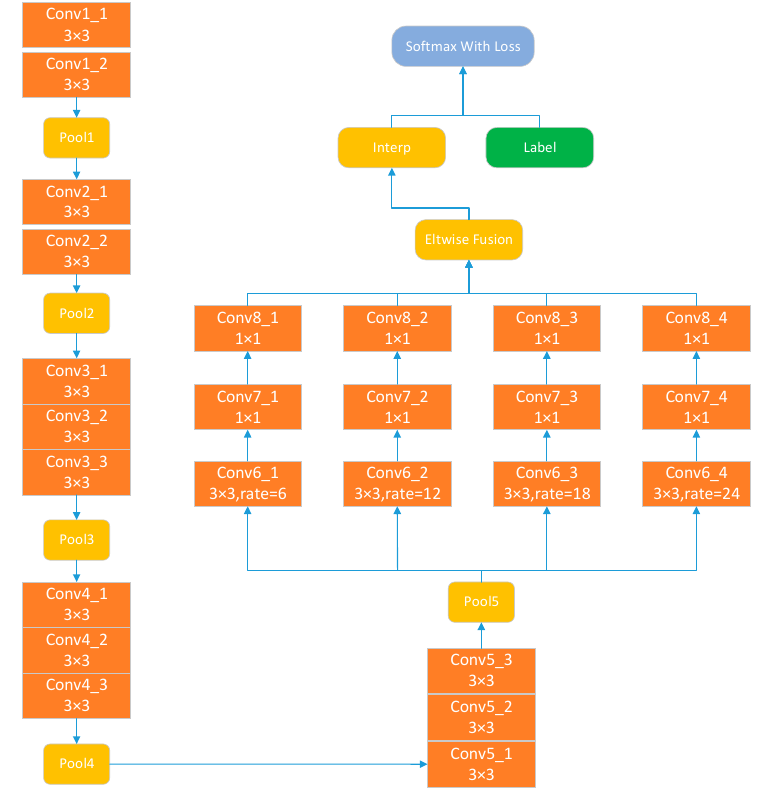
Figure 7. The network architecture of ASPP.